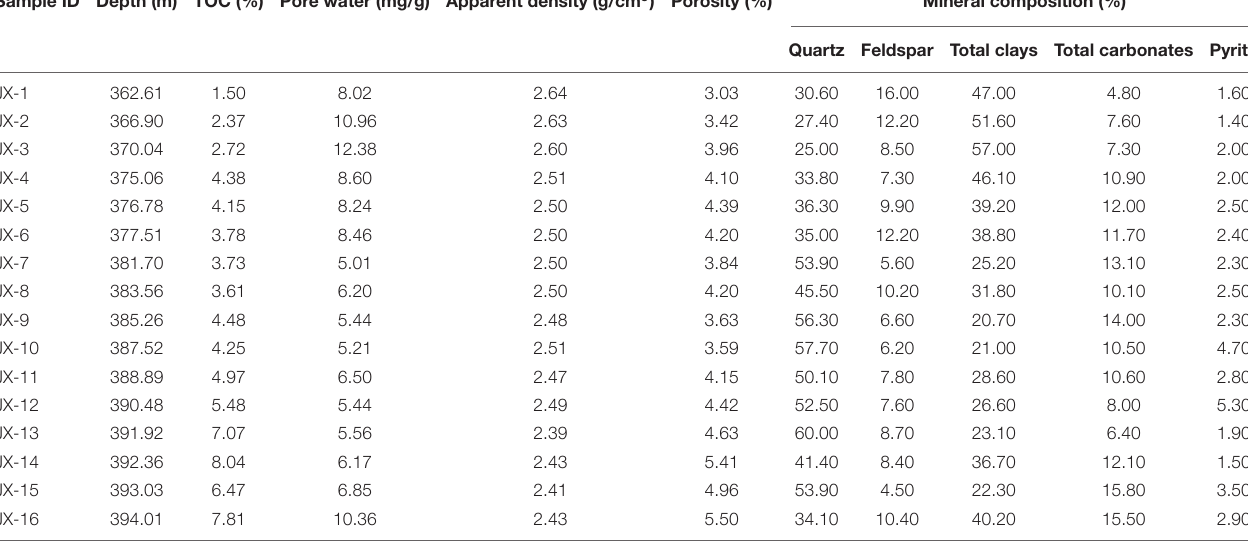
TABLE 1 | Data of geochemistry, mineral composition, and pore water content of the studied shale samples.